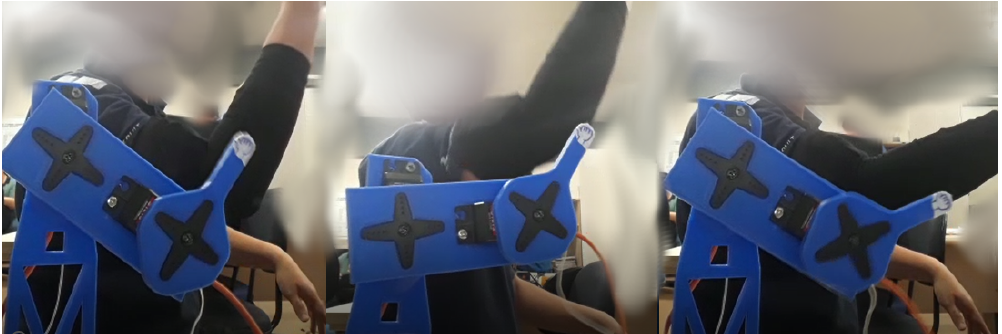
Figure 11. The POC of the robotic arm (in the foreground) mimics the user’s arm. The user (in the background) is wearing the suit with the EMG